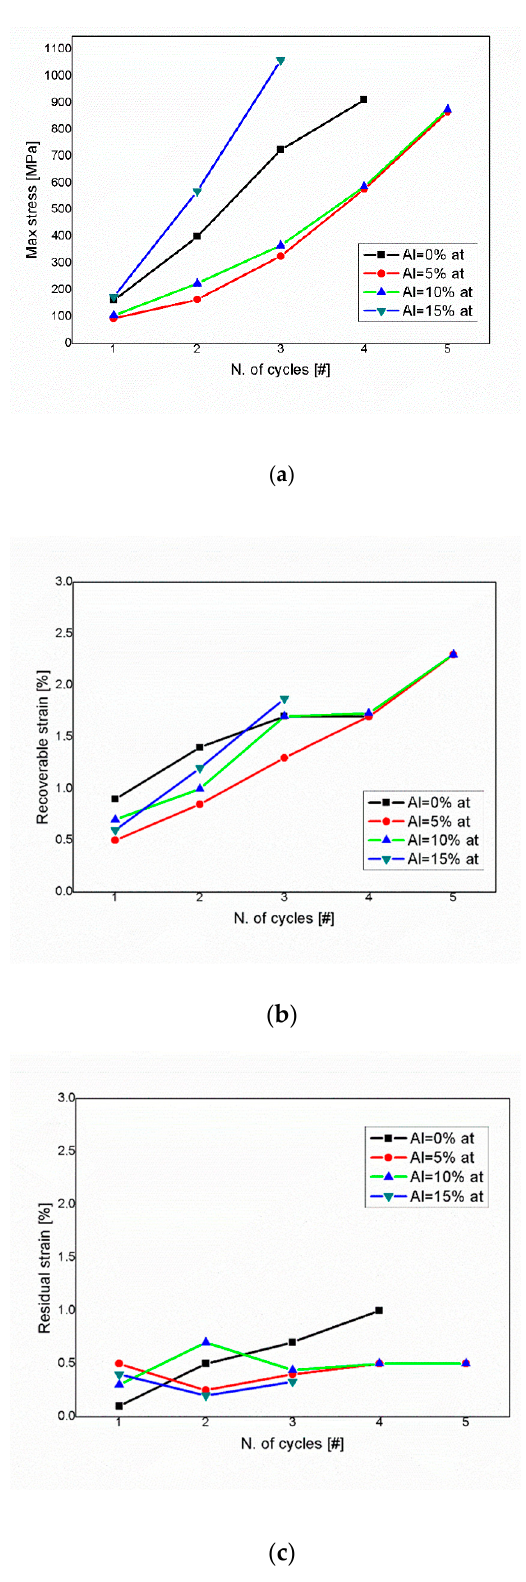
Figure 7. Trend of maximum stress ( a ), recoverable ( b ), and residual strain ( c ) of the Cu (50 − x) Zr 50 Al x alloys with Al = 0, 5, 10, 15 at. %. The stresses and strains are